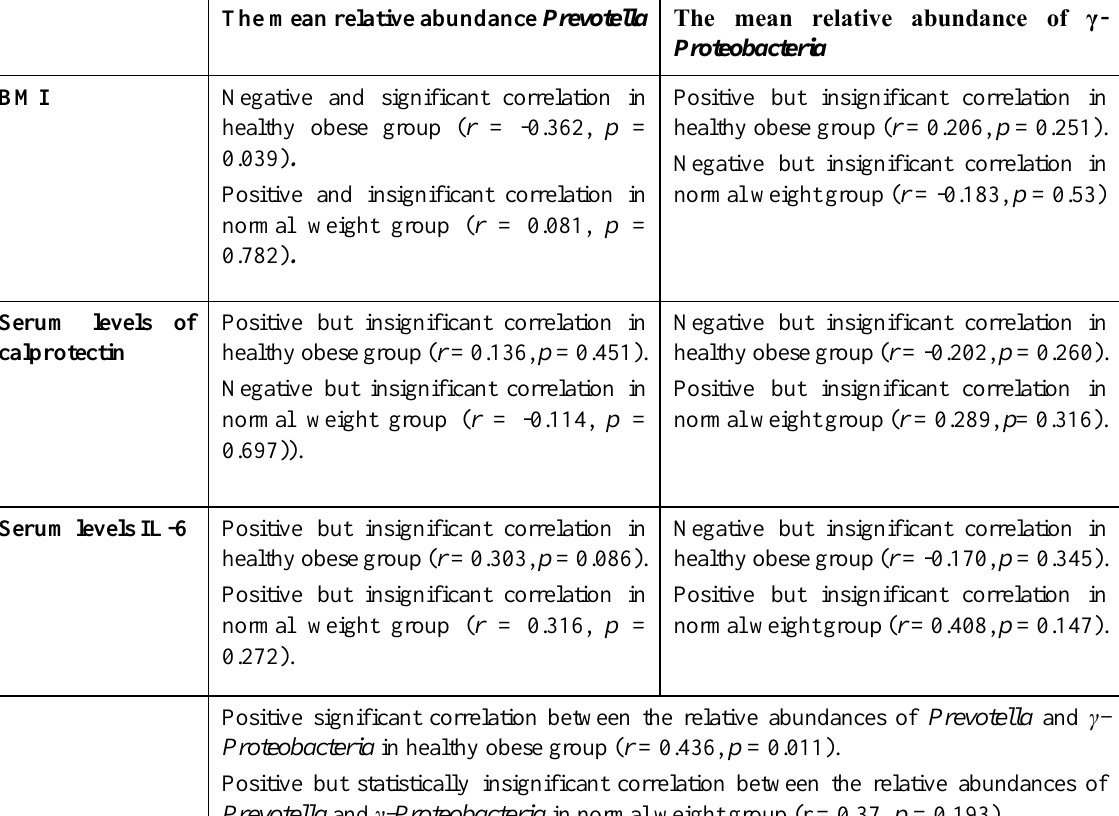
Table 4. The correlations of the relative abundance of Prevotella and γ- Proteobacteria in healthy obese and normal weight groups with different variables in the study.